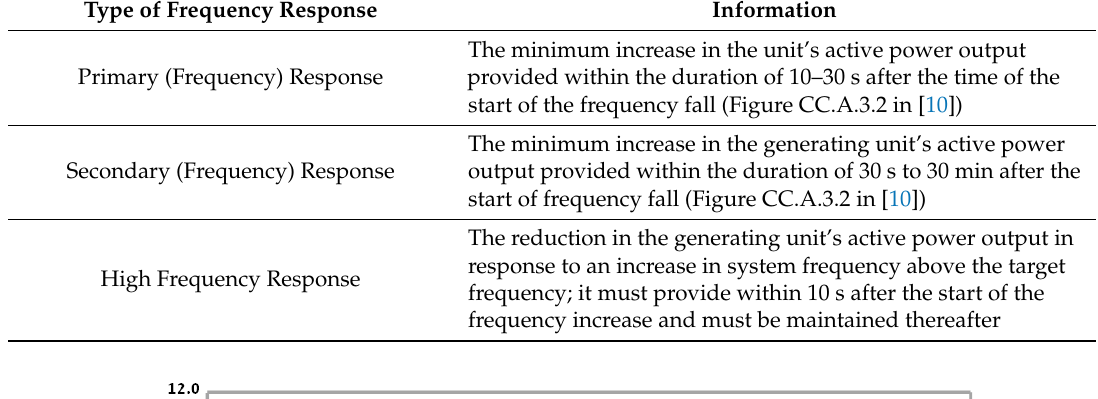
Table 6. The frequency response of generating units specified in the GB Grid Code [1,10].